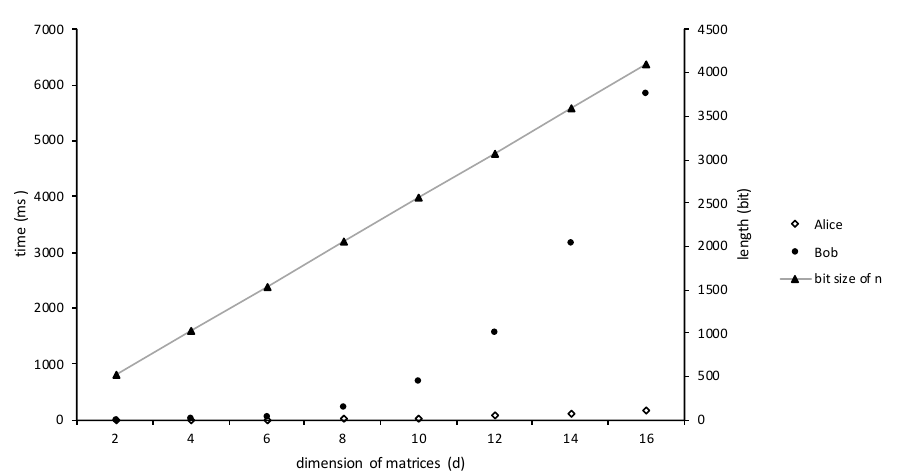
Figure 4. Comparison of calculation times (ms) for Alice and Bob according to d (m = 128).